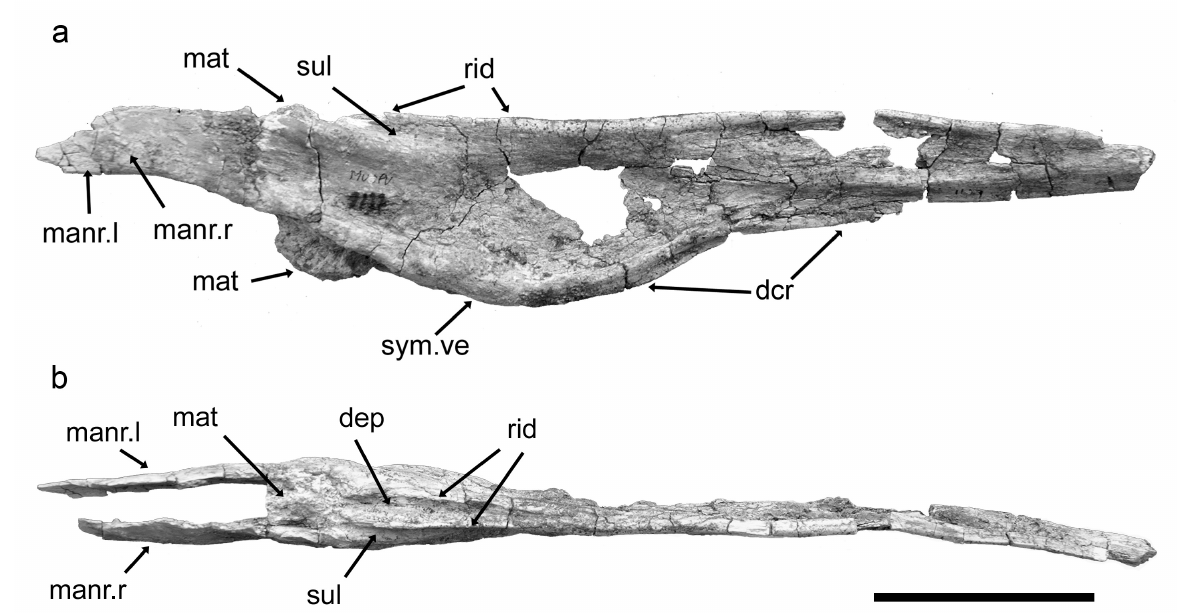
Figure 2 - Argentinadraco barrealensis n. gen, n. sp., lower jaw (MUCPv-1137), ( a ) right lateral view; ( b ) dorsal (occlusal) view. Abbreviations : dep , depression; dcr , dentary crest; manr , mandibular ramus; mat , matrix; rid , ridge; sul , sulcus; sym.ve , ventral segment of the symphysis; l , left; r , right. Scale bar equals 50